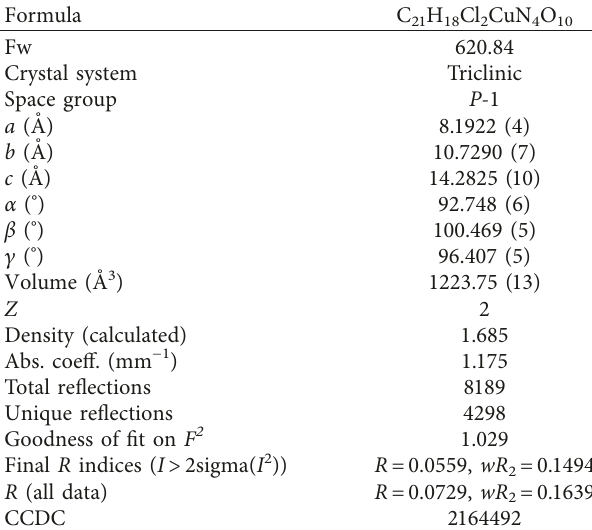
Table 1: The complex 1 ’s crystal